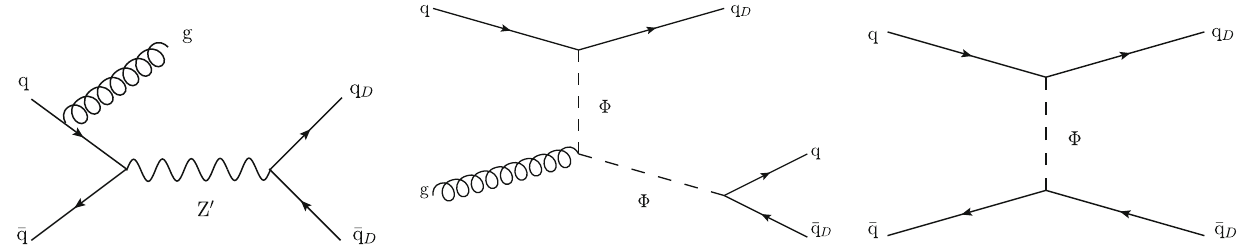
Fig. 7 Processes available via FeynRules in MadGraph5 : pp → gZ (cid:7) → gq D q D (boosted), qg → q D (cid:10) → q D qq D , qq → q D q D